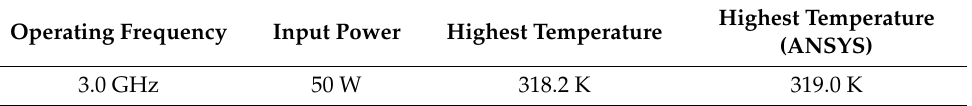
Table 1. Information of antenna element multiphysics simulation.